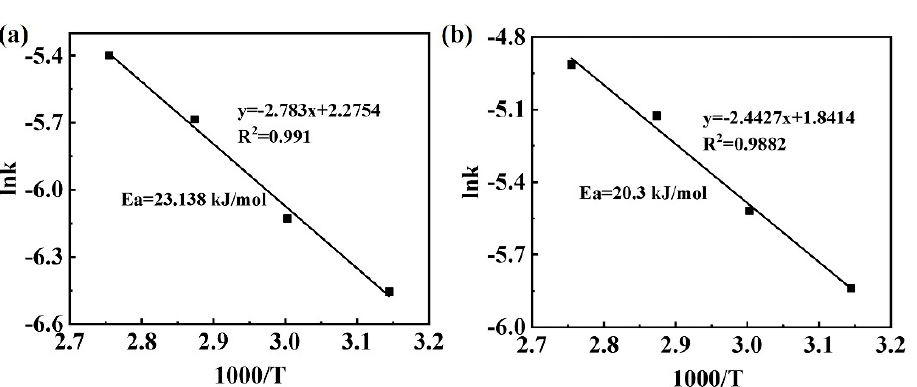
Figure 5. Relationship between lnk and 1000/T during Sn leaching ( a ) chemical control reaction and ( b ) mixed control reaction.